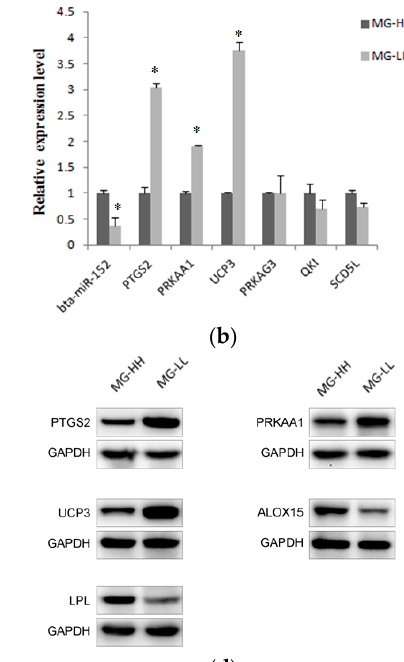
Figure 5. Relative expression analysis of miRNAs and their predicted target genes. ( a ) Bta-miR-33a was down-regulated, which was opposite to the expression level of ELOVL5 , ELOVL6 and SC4MOL in MG-LL; ( b ) Bta-miR-152 was down-regulated in MG-LL and the significantly up-regulated genes were PTGS2 , PRKAA1 and UCP3 ; ( c ) Bta-miR-224 was up-regulated in MG-LL and the corresponding down-regulated genes were ALOX15 , PTGS1 , LPL and GST ; ( d ) Western-blotting results of five target genes. All of the results are expressed as the mean ± S.D. of three replicates. * p < 0.05; GAPDH is internal control.